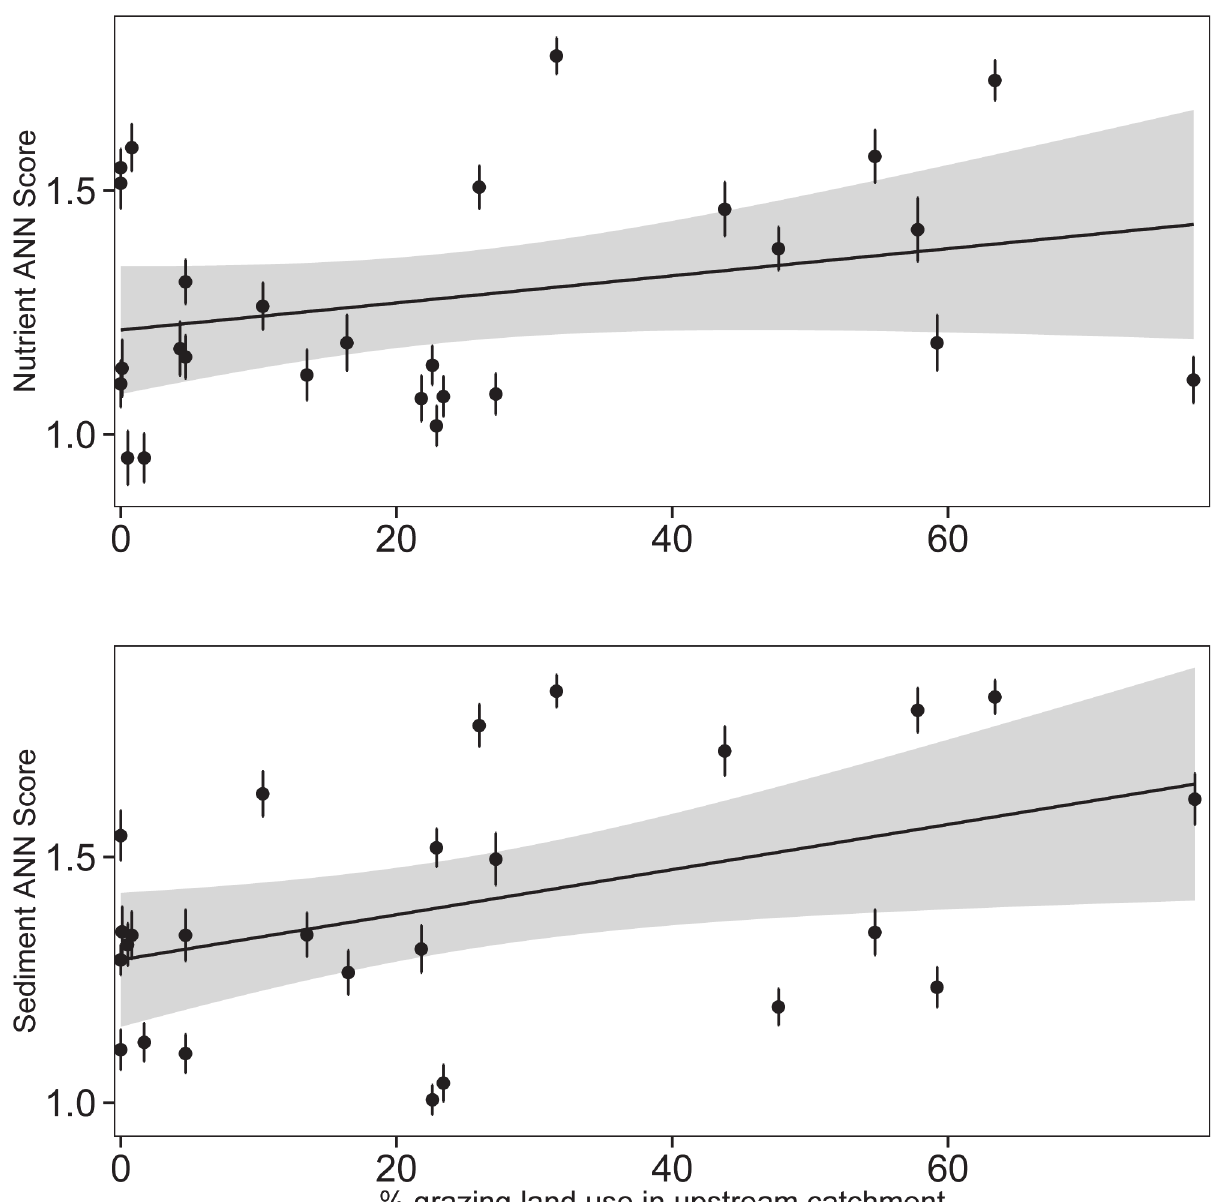
Fig 6. Relationships between ANN predictions and the area proportion of grazing in the catchment. Linear regressions are of predicted scores from nutrient (a) and sediment (b) ANNs against the area proportion of grazing in the catchment. Points plotted are mean ( ± standard error) ANN output scores. Grey shading represents standard error of the linear fit. Linear fits show a significant relationship for fine sediments ( R 2 = 0.18, P < 0.03) but not for nutrients ( R 2 = 0.08, P =